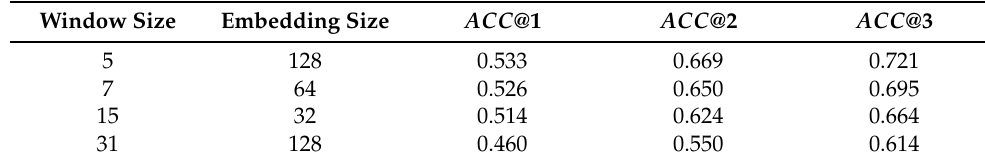
Table A3. Results for the best LW2V-FT model with different window sizes.